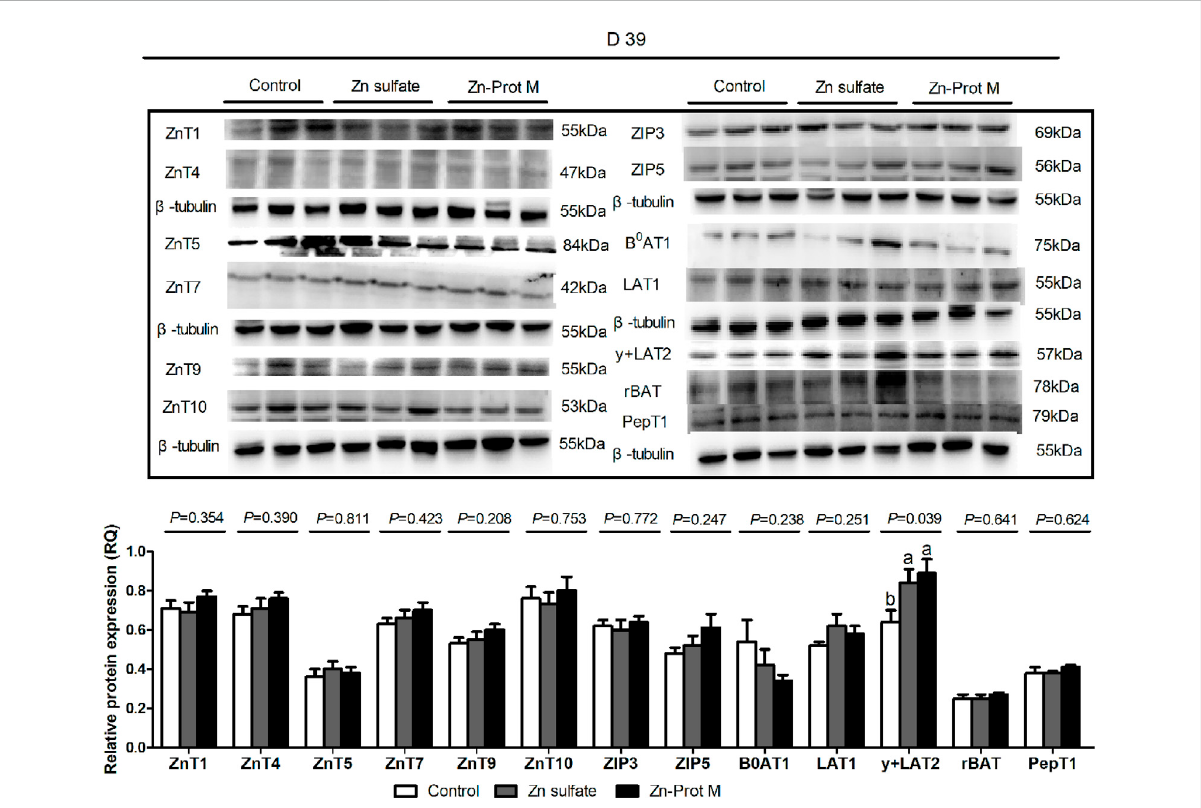
FIGURE 4 Effect of dietary Zn source on the protein expression levels of Zn, amino acid, and small peptide transporters in the duodenum of broilers at 39 days of age. Values are means ± SE, (n = 7/8). Lacking the same letters (a and b) means signi fi cant differences, p < 0.05. ZnT1, zinc transporter 1; ZnT4, zinc transporter 4; ZnT5, zinc transporter 5; ZnT7, zinc transporter 7; ZnT9, zinc transporter 9; ZIP3, Zrt-irt-like protein 3; ZIP5, Zrt-irt-like protein 5; B0AT1, B-0-system neutral amino acid co-transporter; LAT1, L-type amino acid transporter 1; y + LAT2, y + L-type amino acid transporter 2; rBAT, b0,+-type amino acid transporter; PepT1, peptide-transporter 1; Zn-Prot M, Zn proteinate with moderate chelation strength (Qf = 51.6). The protein expression levels were calculated as the relative quantities (RQs) of the target gene protein to the β -tubulin